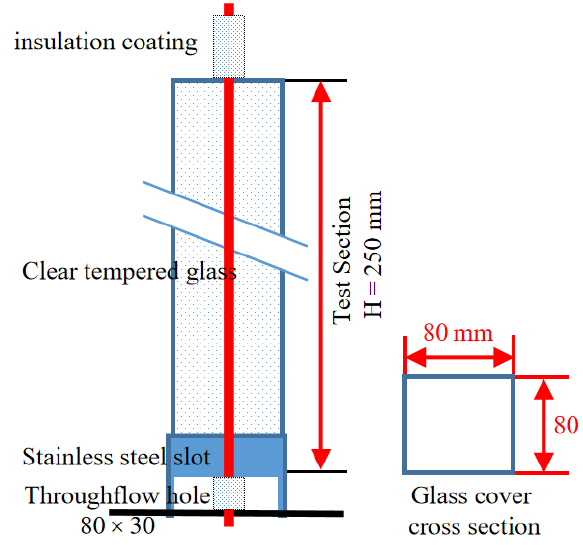
Figure 9. Confined space outside the vertical heat exchange tube.